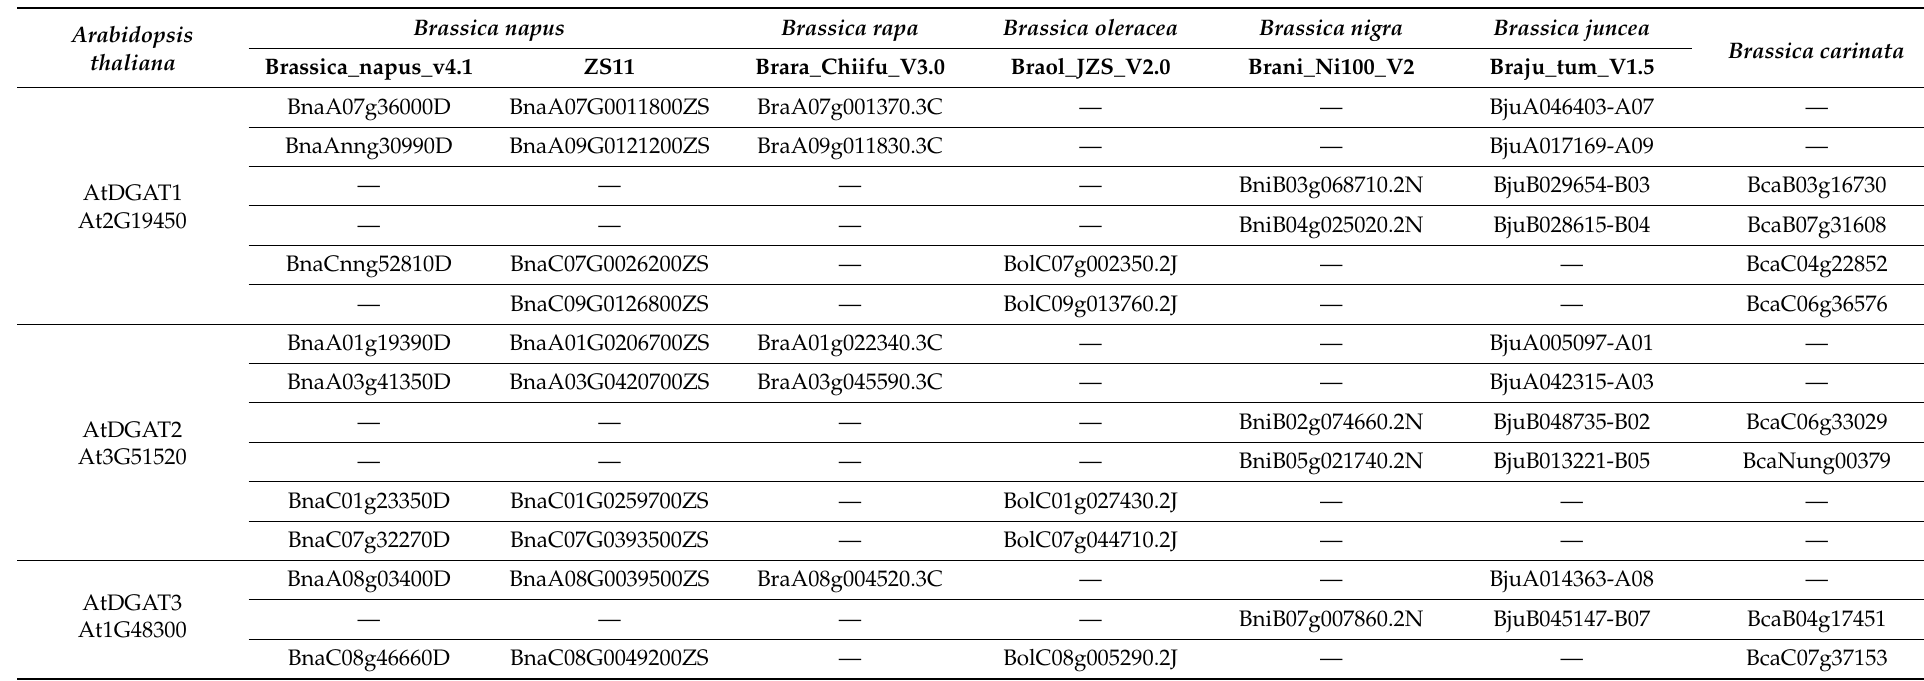
Table 1. Members of the DGAT family in A. thaliana and six Brassica species forming U’s triangle according to their genome databases. Arabidopsis thaliana